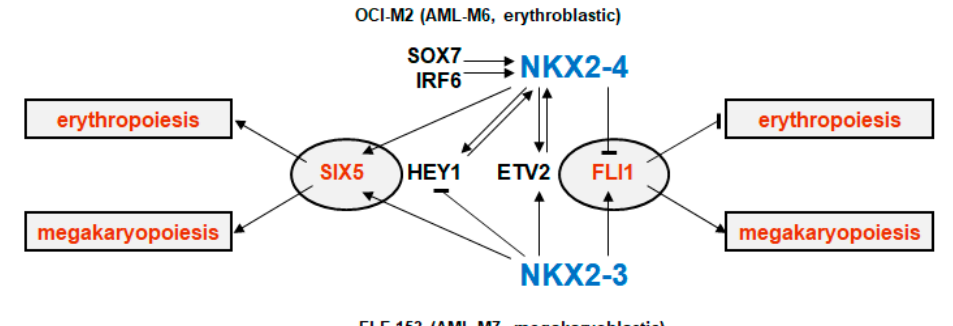
Figure 7. Aberrant gene regulatory network of NKX2-4 in OCI-M2 ( above ) and NKX2-3 in ELF-153 ( below ). These NKL homeobox genes promote respective erythroblastic and megakaryoblastic leukemogenesis via their target genes FLI1 and SIX5 . Endothelial activators of NKX2-4 are indi- cated.